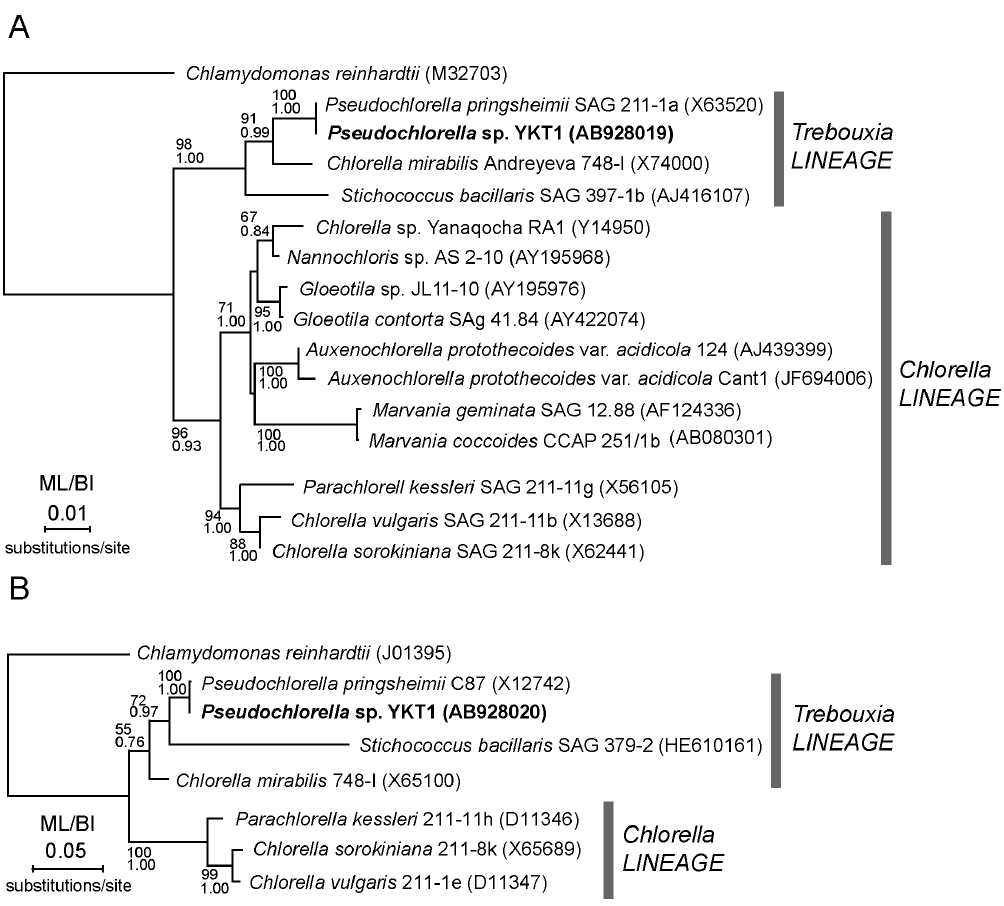
Figure 2. Phylogenetic position of YKT1. Phylogenetic trees based on the 18S rDNA (A) and plastid 16S rDNA sequence (B) are shown. The trees were constructed by a maximum-likelihood method (RaxML 7.2.8) [24]. Maximum likelihood bootstrap values (ML) . 50% by RaxML and bayesian posterior probabilities (BI) . 0.7 by the Bayesian analysis (MrBayes 3.1.2) [25] are shown above the branches. The accession numbers of the sequences are shown along with the names of the species. The lineage designation follows [31]. The branch length reflects the evolutionary distances indicated by the scale bar. (Figure 3A). The results indicate that cells proliferated at pH 2.0 to pH 7.0 and that pH 3.0–5.0 is most suitable for both growth and cell division. Microscopic observation showed that the majority of cells cultured at pH 1.0 was bleached and did not undergo cell division (Figure 3B). Cells cultured at pH 7.0 were